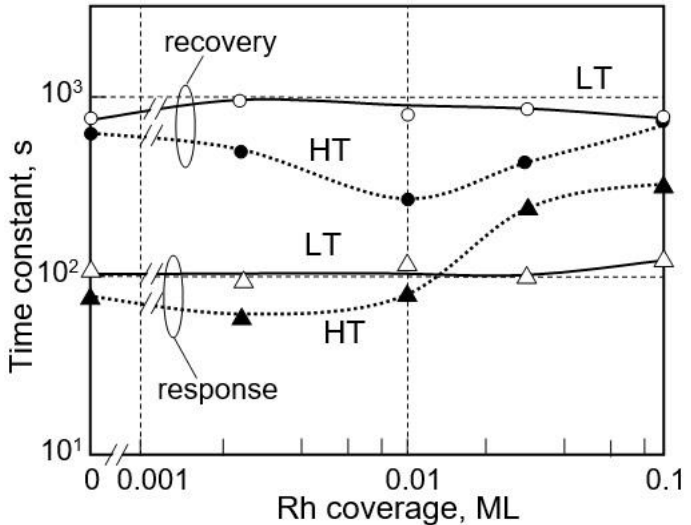
Figure 4. Effect of surface modification of LT and HT In 2 O 3 films with rhodium on the time con- stants of the sensor response to ozone (~1 ppm). Response time (τ res ) and recovery time (τ rec ) were measured at 225 °С.